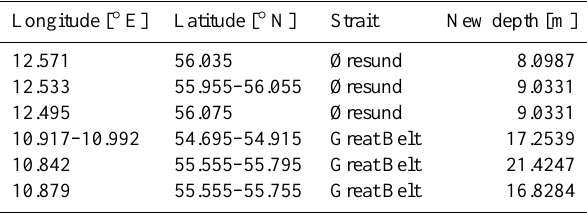
Table 1. List of model grid boxes where the bathymetry was deep- ened to increase the salt water supply to the Baltic